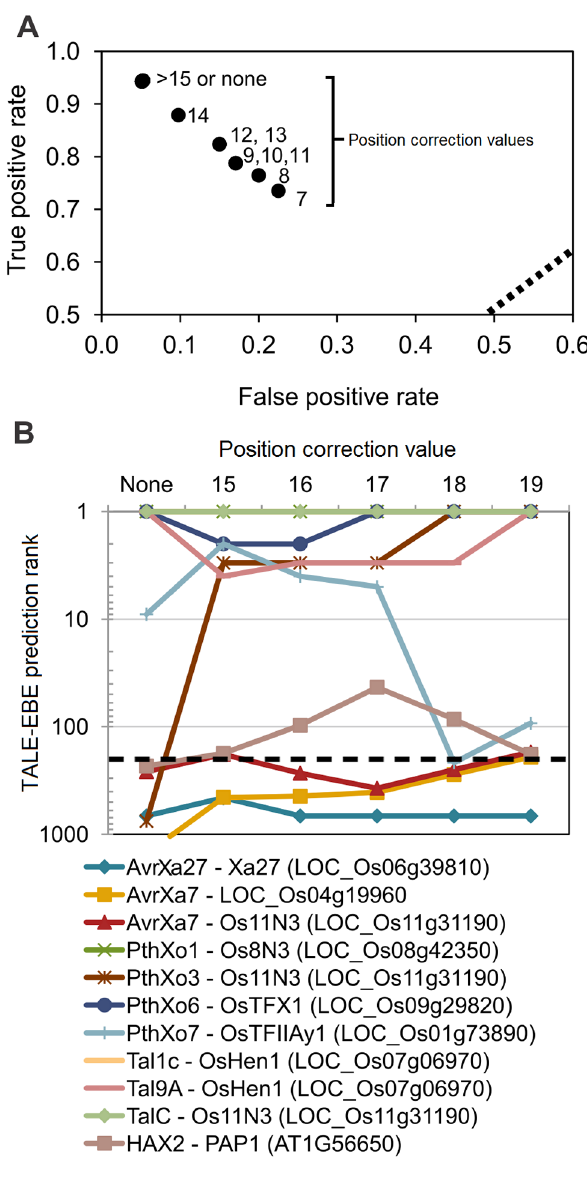
Figure 3. Effects of the Talvez position correction parameter on performances. ( A ) ROC graph showing true positive and false positive rates obtained by screening the validation set with a range (7–25) of position correction values. The data points for positions above 14th as well as for Talvez without position correction (labeled with ‘‘None’’) all superpose on the left uppermost point. ( B ) Rankings of positive control TALE targets among genes predicted to contain EBEs in their promoter regions after screening the Arabidopsis and rice genome with Talvez and position correction parameter value varying between 15 and 19 as well as without position correction. The color coding of the various TALE-target pairs is described in the legend beneath the plot. Rankings for positions above 19 were similar to those without position corrections and were omitted here. The dashed line corresponds to rank values equal to